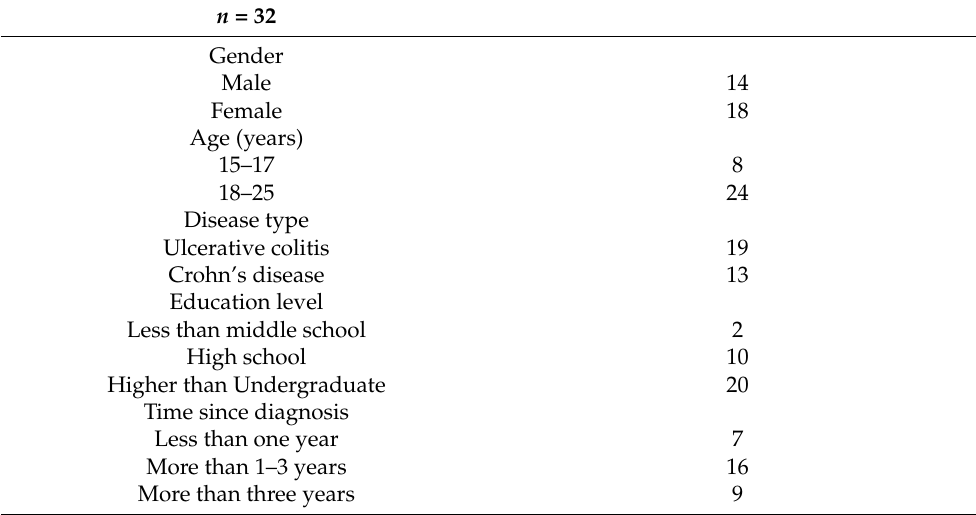
Table 1. Demographic characteristics of the